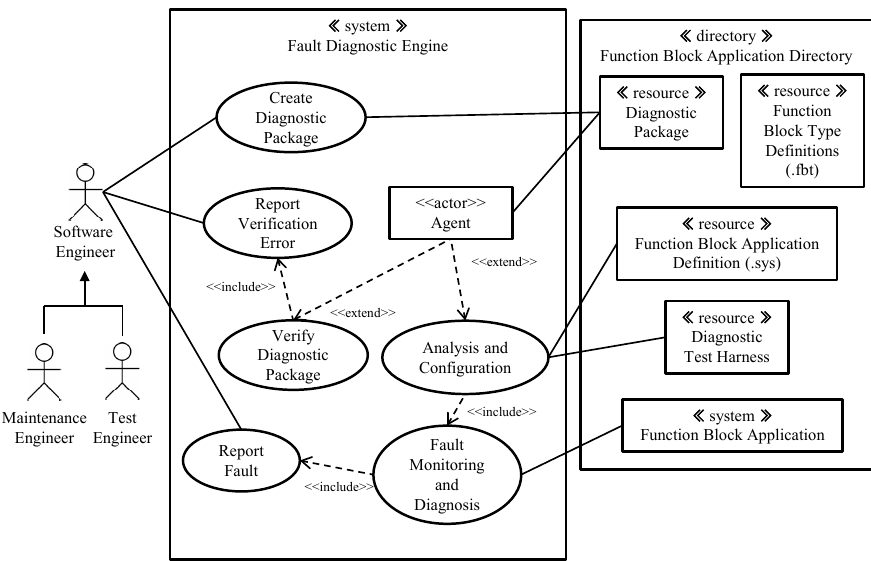
Figure 4. The system context view of the fault diagnostic engine.